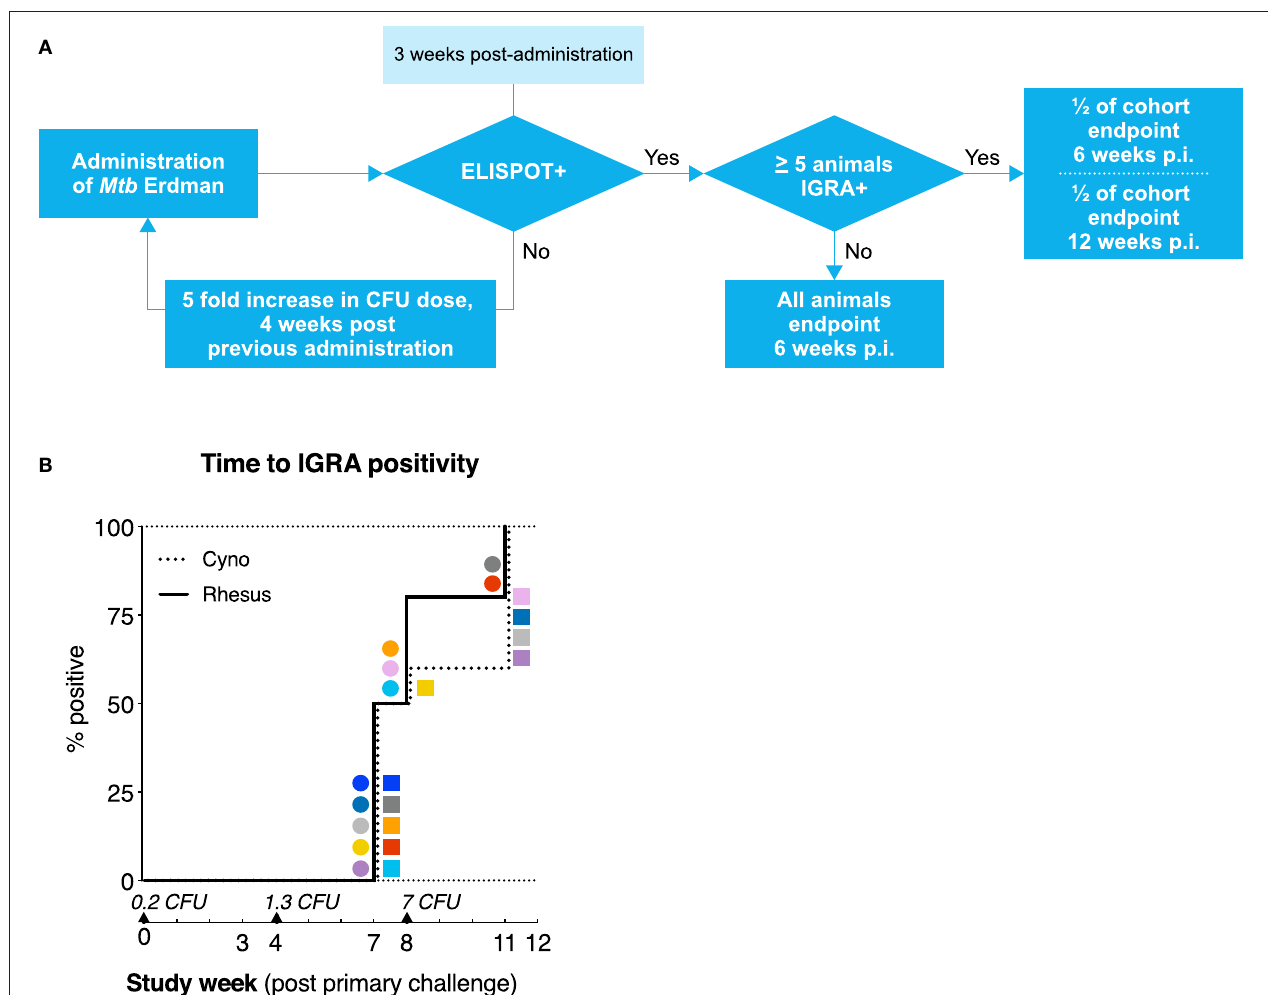
FIGURE 1 | Mtb dose escalation challenge in cynomolgus and rhesus macaques. (A) Schematic representation of the minimal Mtb dose-finding strategy applied in this study. Rhesus and cynomolgus macaques, n = 10 each, were endobronchially challenged with an initial dose of 0.2 CFU of Mtb strain Erdman, after which infection take was determined by means of an Mtb specific IFN γ ELISPOT. Non-infected (read: IGRA–) animals were challenged with an increasing dose of Mtb until ELISPOT-positivity was obtained. ELISPOT-positive animals were randomly assigned and sacrificed either at 6 ( n = 6 per species) or 12 weeks ( n = 4 per species) after infectious Mtb exposure. (B) Kaplan-Meier curve depicting the rate of IFN γ ELISPOT positivity/IGRA conversion. Mtb challenge events are indicated by triangles along the x-axis, accompanied by the calculated (extrapolated) challenge dose, verified by quality control plating. Squares represent individual cynomolgus macaques, circles represent individual rhesus macaques. Color coding per individual, as defined in Table 1 , is consistently applied